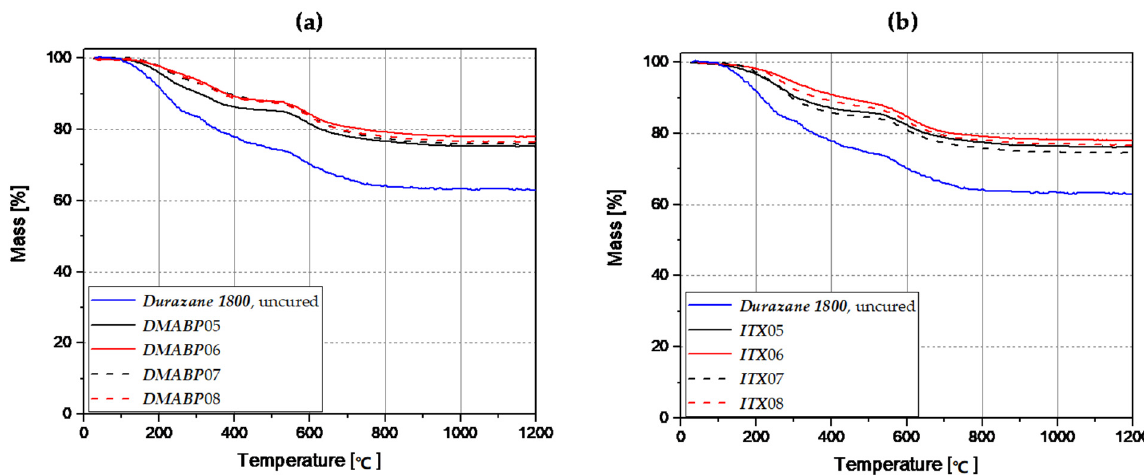
Figure A1. Thermograms of samples cured by an LED source ( λ = 405 nm) measured in nitrogen atmosphere: ( a ) DMABP 05–08 and ( b ) ITX 05–08. The black curves are mixtures of Durazane 1800 with 1 wt% photoinitiator concentration and the red curves are mixtures of Durazane 1800 with 3 wt% PI concentrations. The dotted curves were cured in inert